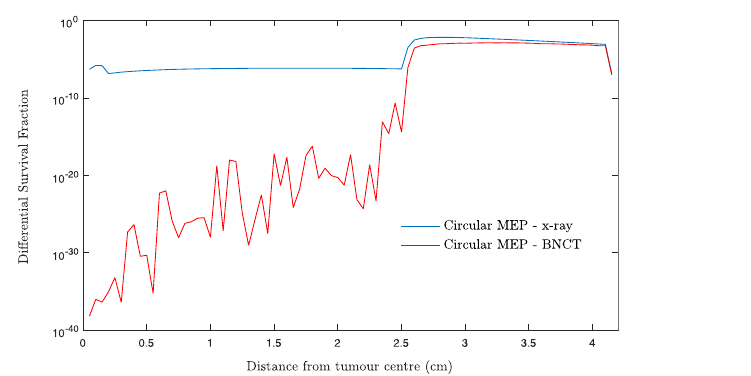
Figure 5. Differentiated SF versus distance from tumour centre for two scenarios: homogeneous-hypoxic GBM models treated by (1) BNCT; and (2) conventional x-ray therapy. These graphs are obtained applying “circular” MEP model and 2.0 cm CTV (2.5 cm beam radius).